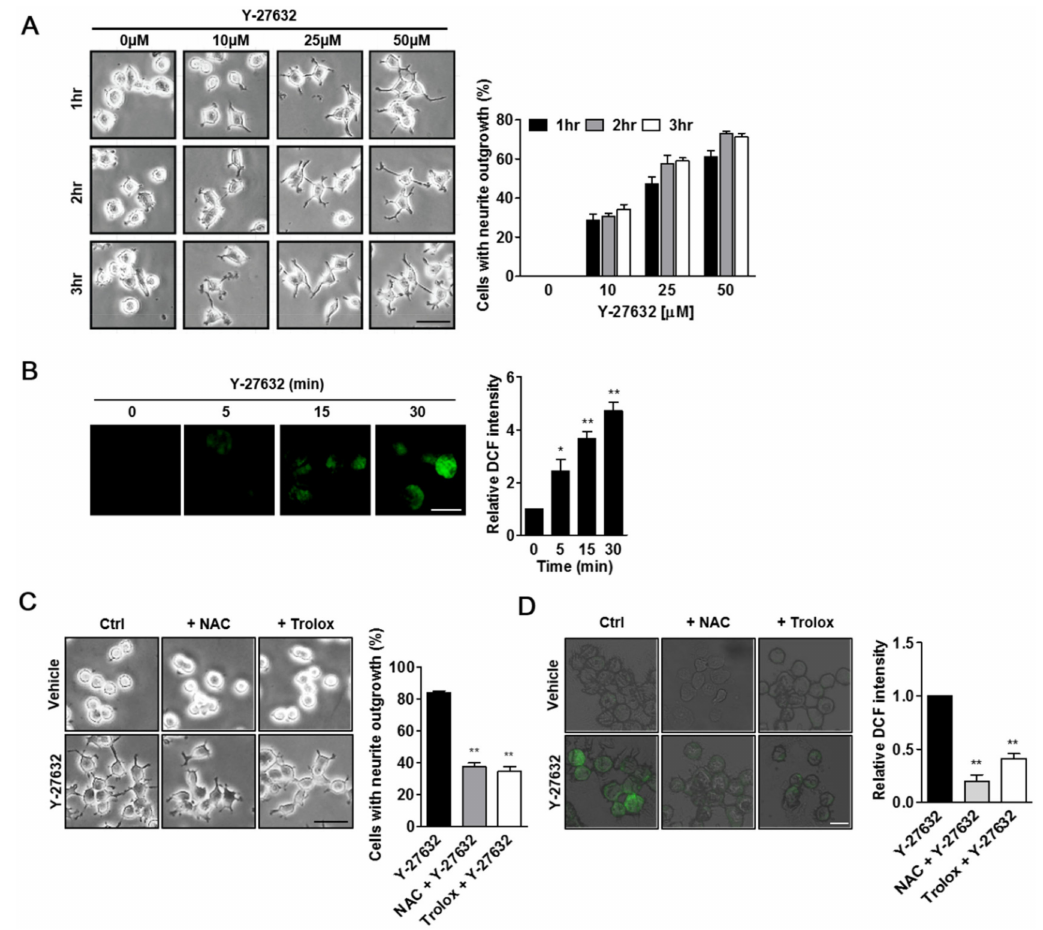
Figure 1. Y-27632 induces neurite outgrowth and ROS production in PC12 cells. ( A ) PC12 cells were exposed to di ff erent concentrations of Y-27632 (10–50 µ M) for the indicated times. Microphotographs of the cells were taken, and representative images are shown in the left panel. Cells with neurite processes longer than the cell body diameter were counted, and the percentages of neurite-containing cells are shown in the right panel. Note that neurite outgrowth was promoted by Y-27632 in a time- and concentration-dependent manner. Scale bar = 50 µ m. ( B ) PC12 cells were incubated with 2 µ M DCF-DA and then treated with 25 µ M Y-27632 for 30 min. The fluorescence intensity was measured using a confocal microscope. Scale bar = 20 µ m. Culture images are at a magnification of 63 × . ( C ) PC12 cells were treated with 25 µ M Y-27632 for 2 h in the presence or absence of ROS scavengers, such as 5 mM NAC and 500 µ M trolox. Cells with neurite processes longer than the cell body diameter were counted, and the percentages of neurite-containing cells were determined. Scale bar = 50 µ m. Culture images are at a magnification of 20 × . ( D ) PC12 cells were incubated with 2 µ M DCF-DA and treated with 5 mM NAC or 500 µ M trolox. Cells were then exposed to 25 µ M Y-27632 for 1 h. The fluorescence intensity was measured using a confocal microscope. Note that ROS were generated by Y-27632, and ROS scavengers, such as NAC and trolox, prevented ROS production and neurite outgrowth triggered by Y-27632. Scale bar = 20 µ m. Culture images are at a magnification of 40 × . The data represent the means ± S.E.M. of at least four independent experiments. * p < 0.05; ** p < 0.01 compared with the control group (vehicle or Y-27632 alone